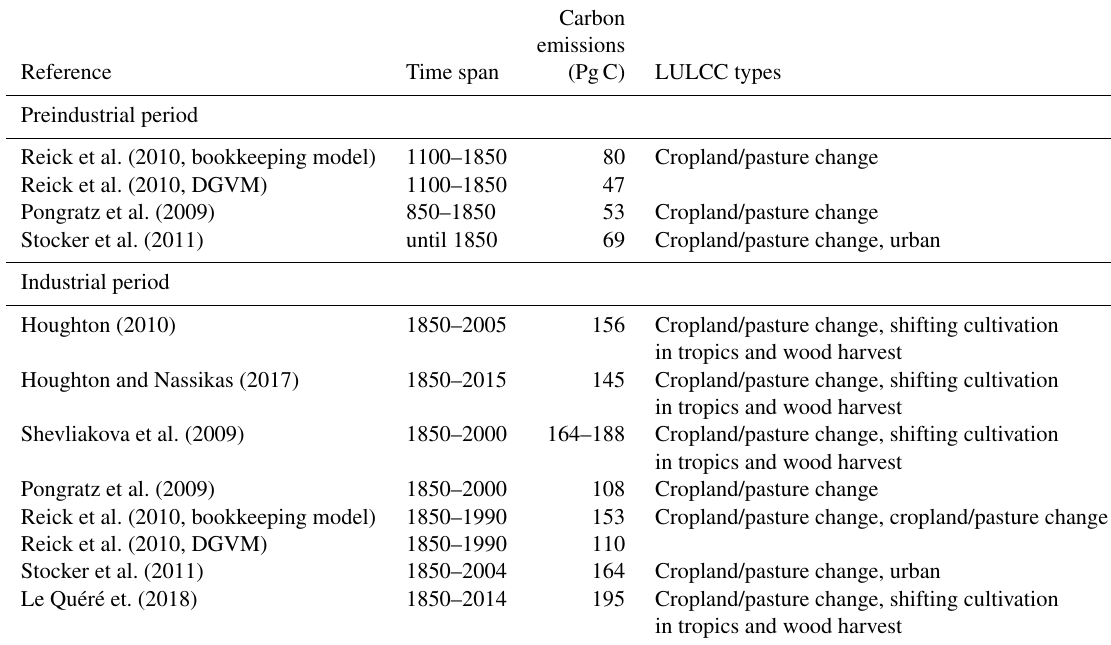
Table 3. Summary of carbon emissions due to LULCC from available studies in the preindustrial and industrial periods.